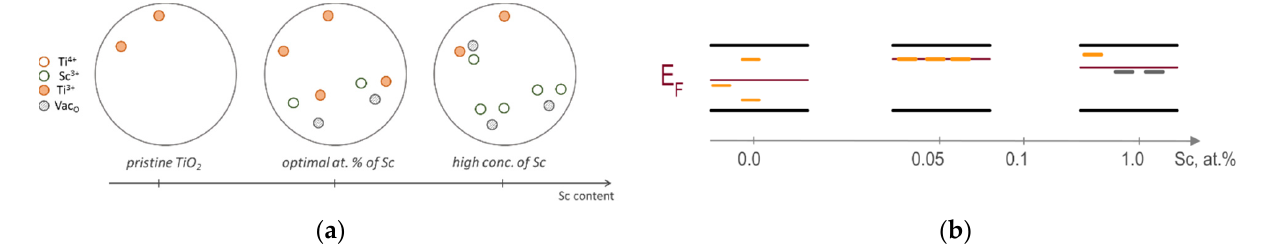
Figure 7. Illustration of the ( a ) spatial and ( b ) energy redistribution of the defect states in Sc-doped TiO 2 . Yellow dashes are Ti 3+ centers, gray are deep centers of various types.